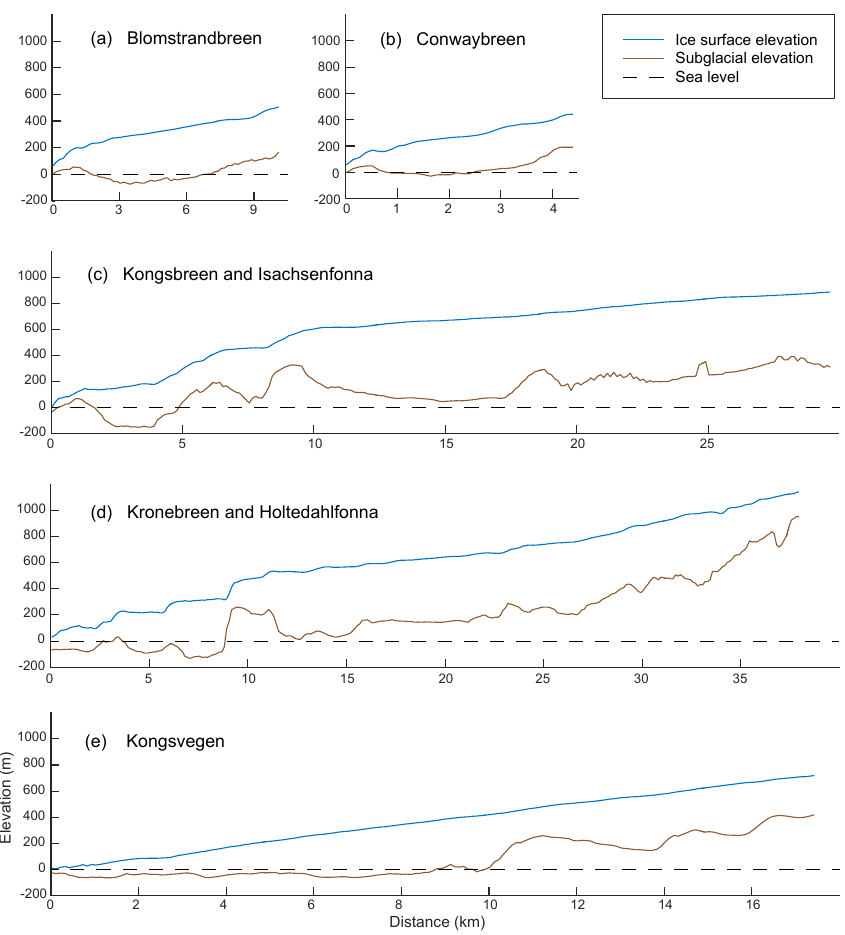
Figure 7. Glacier surface elevation in 2014 (blue line) and subglacial elevation (brown line) along the glacier ice flow centre lines (Fig. 5b) of (a) Blomstrandbreen, (b) Conwaybreen, (c) Kongsbreen and Isachsenfonna, (d) Kronebreen and Holtedahlfonna, and (e) Kongsvegen. Dashed black line is present-day sea level. Distance is measured from the present-day glacier front. Notice that the x axis scale varies between the